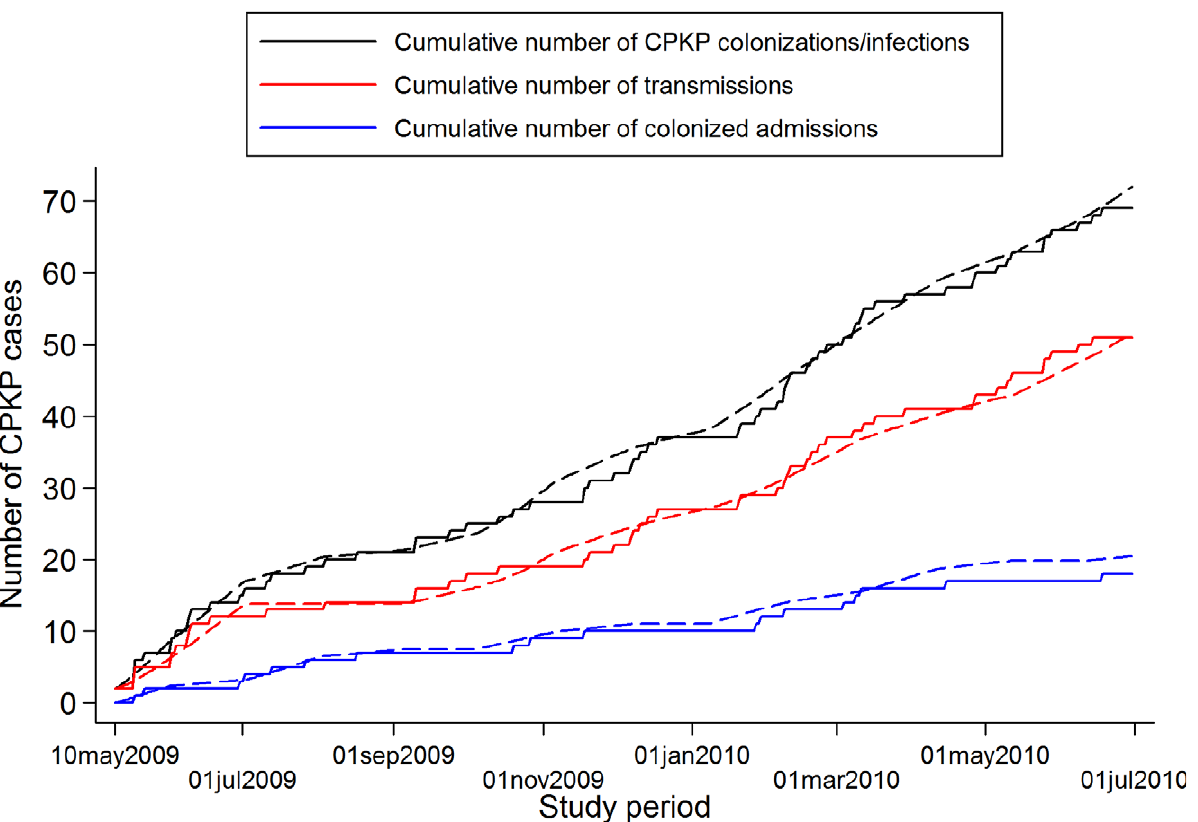
Figure 2. Observed number of patients with CPKP and model fit. Observed cumulative number of CPKP colonized patients (admissions and colonizations within the unit), CPKP colorizations within the unit and CPKP colonized admissions (solid lines) along with the corresponding model fit (dashed lines).